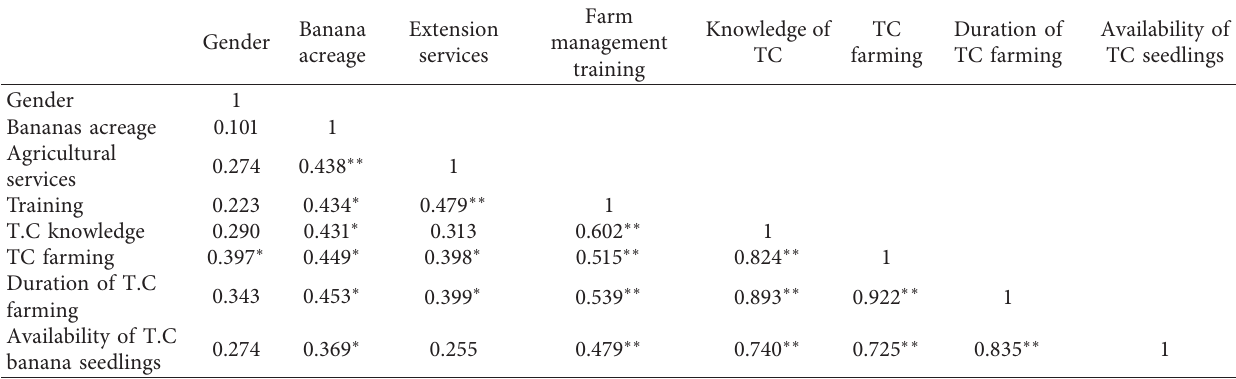
Table 4: Pearson’s correlation coefficient for tissue-cultured bananas farming